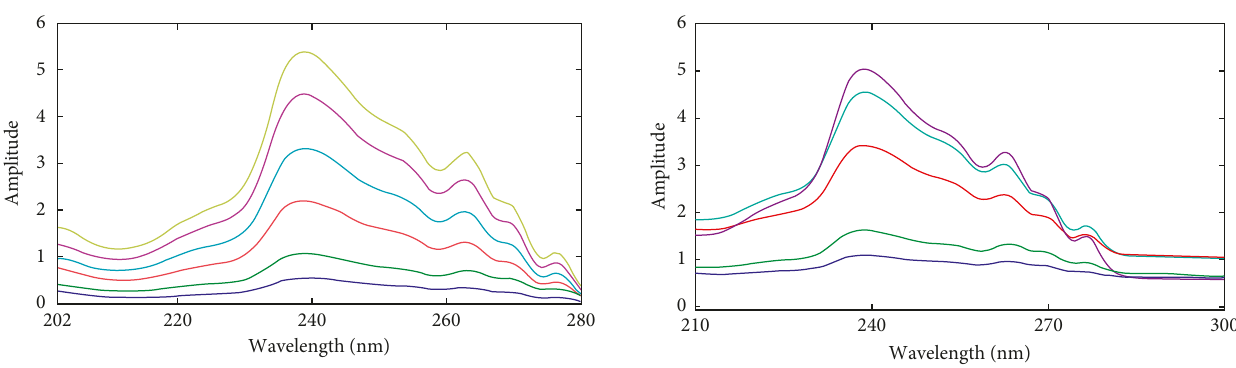
Figure 3: Ratio spectra of aclidinium at various concentrations (5–50 µ g/mL) using 8 µ g/mL of formoterol as a divisor.